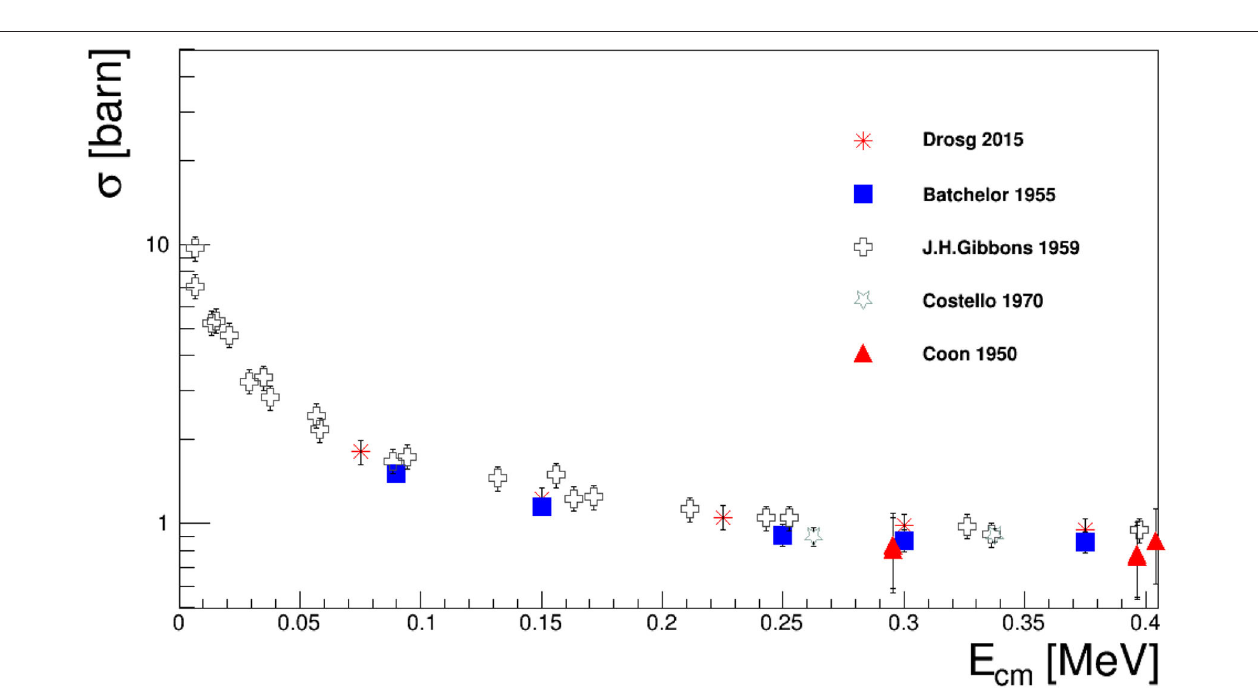
Frontiers in Astronomy and Space Sciences |